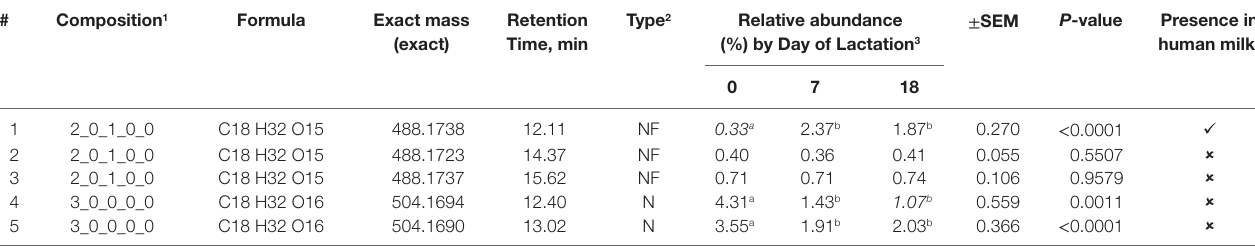
TaBle 2 | Qualitative profiles and relative abundances of oligosaccharides (Os) in porcine milk throughout lactation. # composition